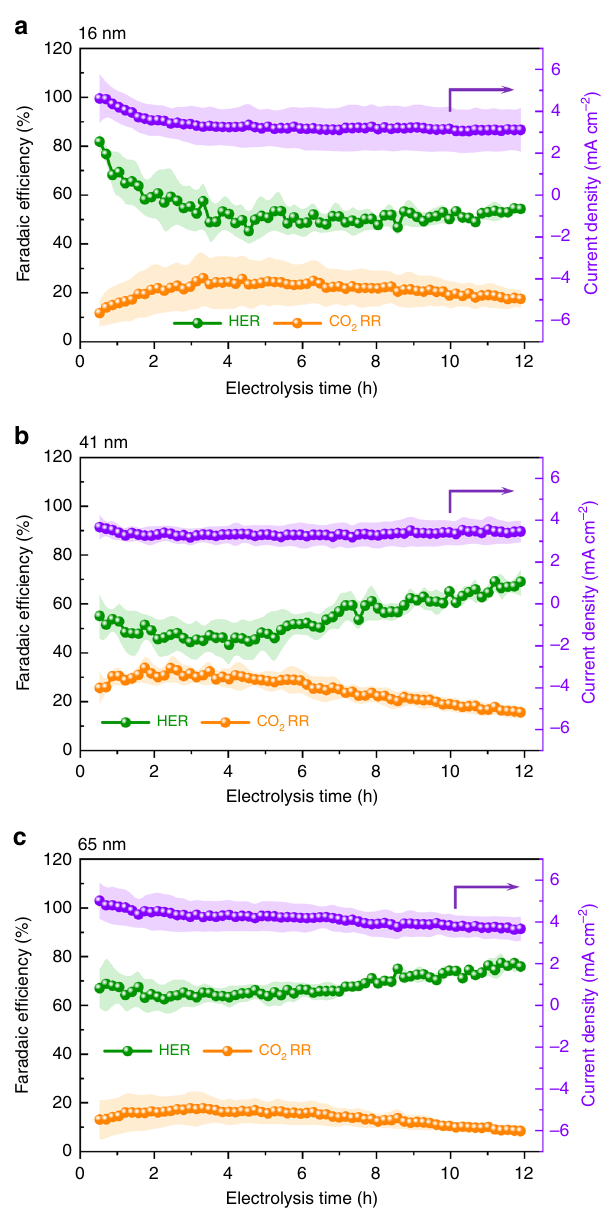
Fig. 3 Electrocatalytic performance over time of the CuNCs. a – c Faradaic ef fi ciency of gaseous products and current density from CuNCs of three different sizes: a 16 nm, b 41 nm, c 65 nm, collected during a 12 h-course of CO 2 RR. Shaded areas of each line show standard deviations from three independent